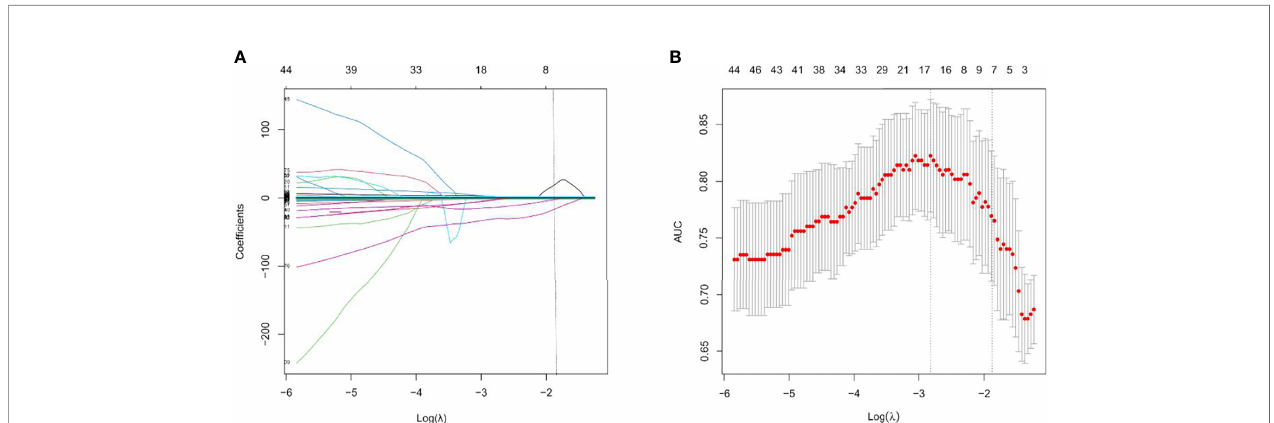
FIGURE 2 | Feature selection with the least absolute shrinkage and selection operator (LASSO) binary logistic regression model. (A) LASSO coef fi cient pro fi les of the features. Each colored line represents corresponding coef fi cient of each feature. Vertical dotted line was drawn at the selected l , where nonzero coef fi cients were obtained with 7 features; (B) Tuning parameter ( l ) selection of LASSO model. The area under curve (AUC) was drawn versus log( l ). Vertical dotted line were plotted at the best value with using 5-fold cross-validation to tune parameter ( l ) selection in the LASSO